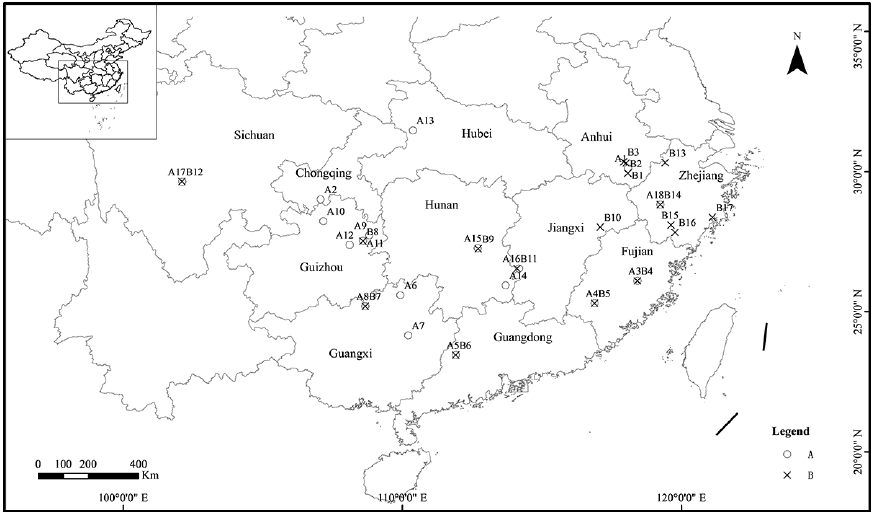
Figure 1. The 35 sampling locations in China. The circles represent 18 locations of lineage A. The crosses represent 17 locations of lineage B. Location details are shown in Table 1.